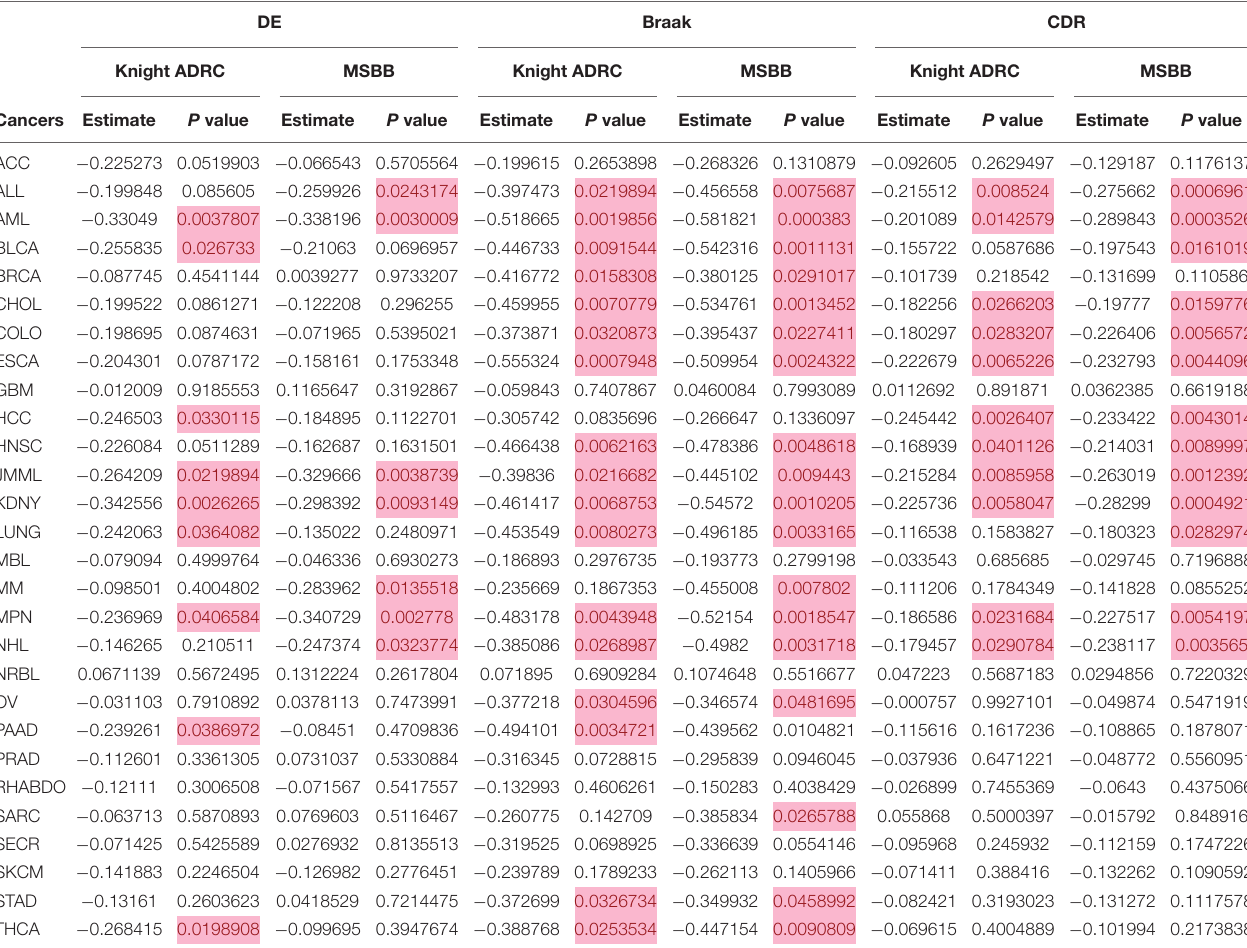
TABLE 1 | CircRNA expression patterns are negatively correlated in AD and some